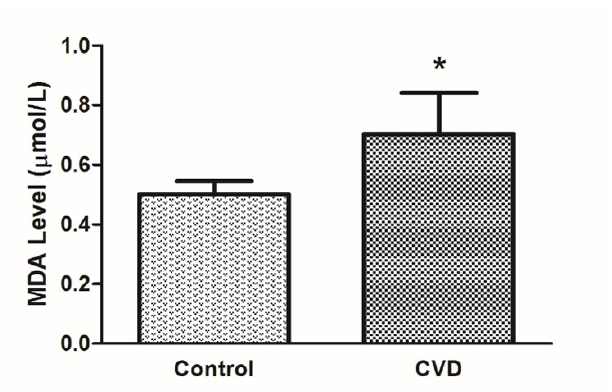
Fig. 1 - Determination of malondialdehyde level as a biomarker of oxidative stress in plasma for all groups (controls and patients with CVD). The symbols denote significant differences from the control group at (*) P<0.05 by using one-way ANOVA with LSD (least significant difference) post hoc